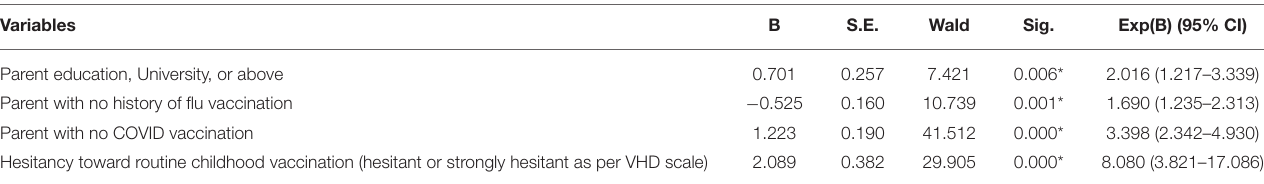
TABLE 3 | Multivariate analysis on predictors of hesitant or strongly hesitant position in parents toward childhood COVID-19 vaccination based on Oxford COVID-19 vaccine hesitancy scale (OC19-VHS) (28).